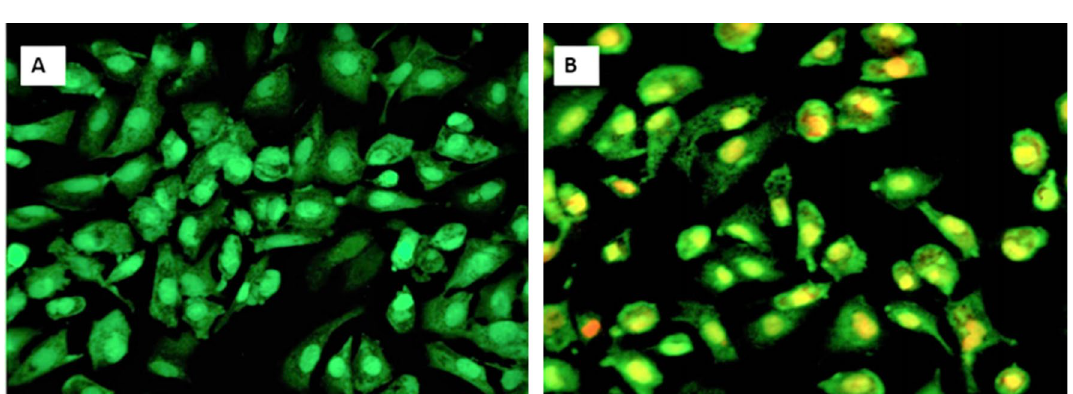
Figure 14. Acridine Orange staining assay; ( A ) Human Lung Adenocarcinoma Control cells; ( B ) Human Lung Adenocarcinoma test sample treated (exopolysaccharide isolated from Nitzschia palea